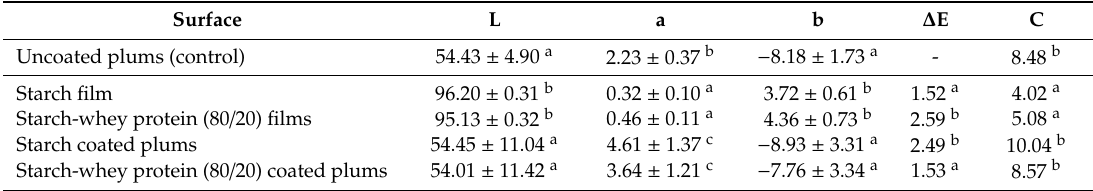
Table 1. Colour parameters of the surface of non-coated plums (control), of starch films, starch-whey protein (80 / 20) films, starch coated plums, of starch-whey protein (80 / 20) coated plums. Thicknesses of films and coatings were similar (about 28 × 10 − 6